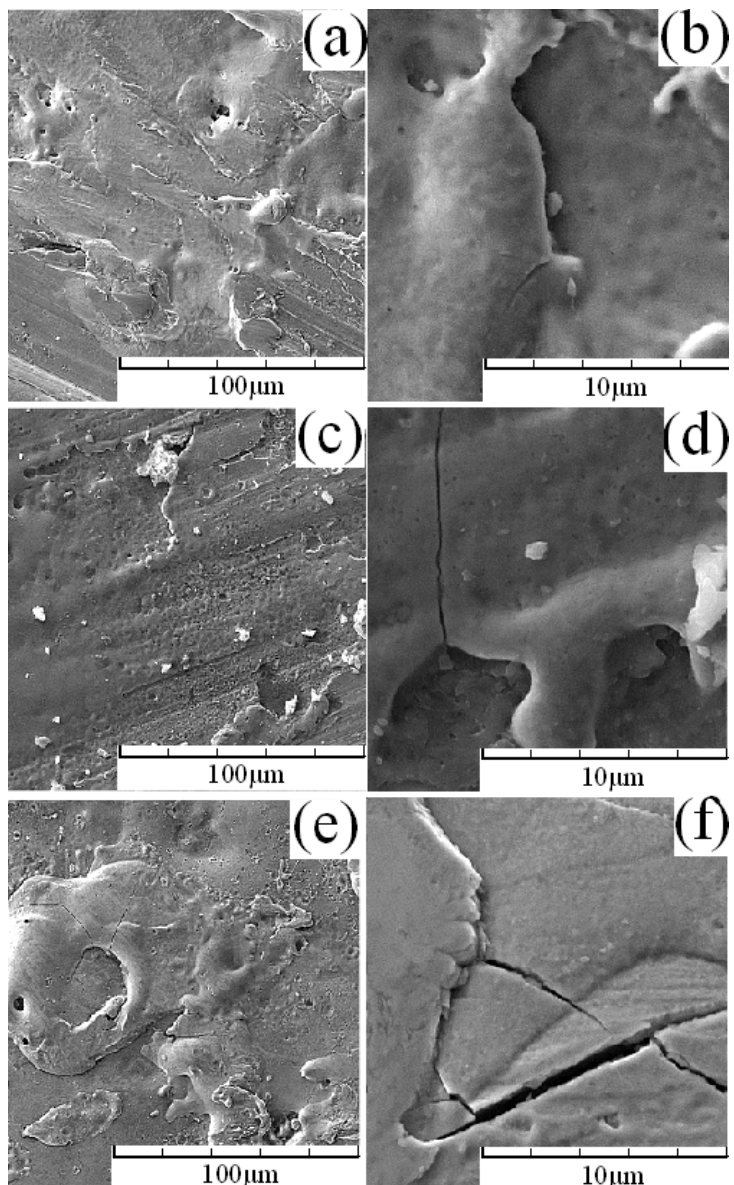
Figure 9. Scanning electron microscopy (SEM) micrographs from surface of samples AFD150510, AFD351150, AFD250550 in magnification 1000 ( a , c , e ) and 10,000 ( b , d , f ) respectively.